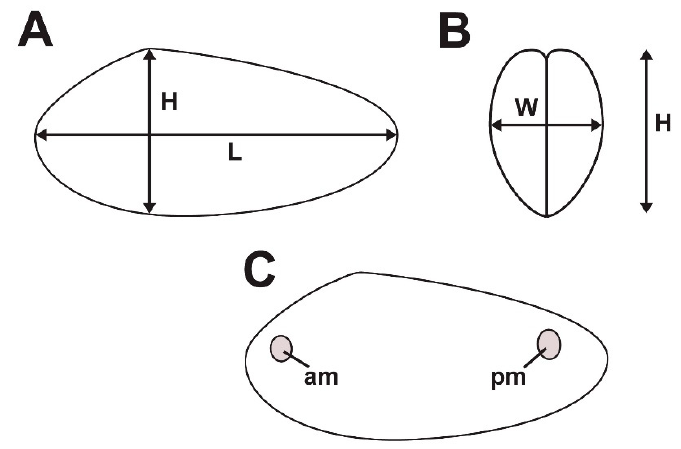
Figure 6. Definitions for shell shape parameters used in this study. ( A ) Shell elongation. Shell length (L) = maximum anterior-posterior length of shell. Shell height (H) = maximum length of shell through umbo and perpendicular to shell length. Shell elongation = L/H; ( B ) Shell obesity. Shell width (W) = maximum distance between valves. Shell obesity = W/H; ( C ) Muscle scar size. Anterior muscle scar (am); Posterior muscle scar (pm). Plan area of shell = area of shell midplane inside shell perimeter. Relative muscle scar size = (area of am + area of pm)/(plan area of shell). Although muscle scars undoubtedly reflect attachment sites of the adductor muscles, no attempt was made to identify attachments of other muscle sets. Measurements were made from shell photographs with Bersoft mensuration software.